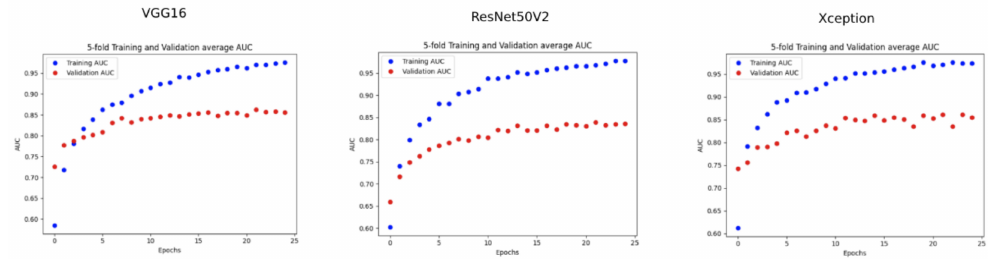
Figure 8. Five-fold cross-validation average AUC over 40 epochs.